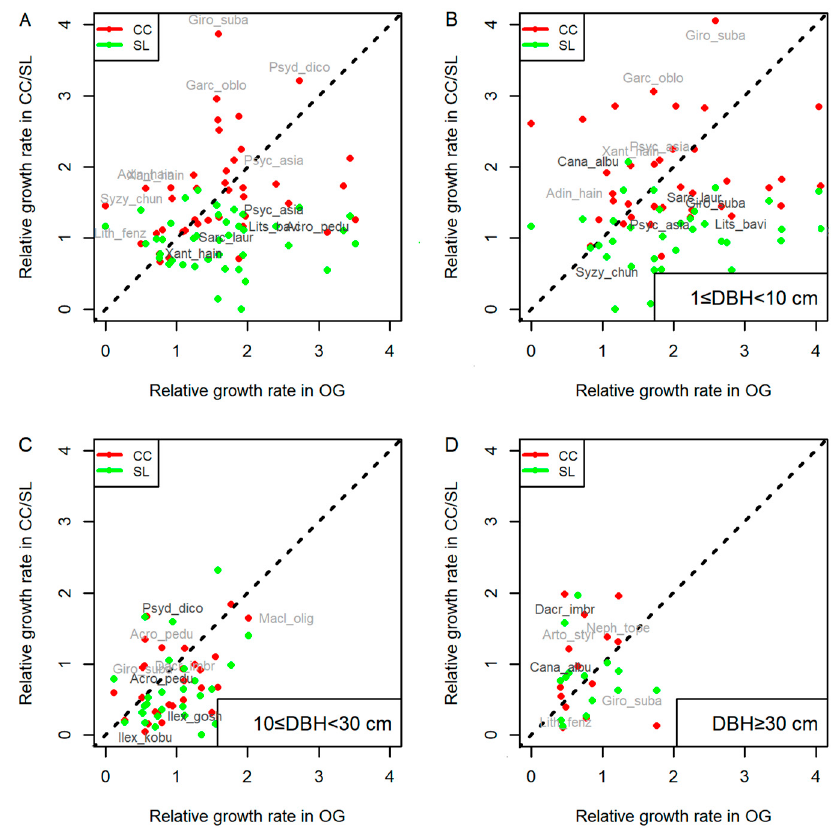
Figure 4. The relative growth rates of food plants in three different disturbances (clear-cutting, CC; selectively logged, SL; old-growth forests, OG) for all individuals ( A ), small trees (1 cm ≤ DBH < 10 cm, B ), medium trees (10 cm ≤ DBH < 30 cm, C ) and large trees (DBH ≥ 30 cm, D ). Red points and light gray words indicate species in CC forests, while green points and dark gray words indicate species in SL forests. Species represented by abbreviations in this figure can be seen for detailed information in Table S1.